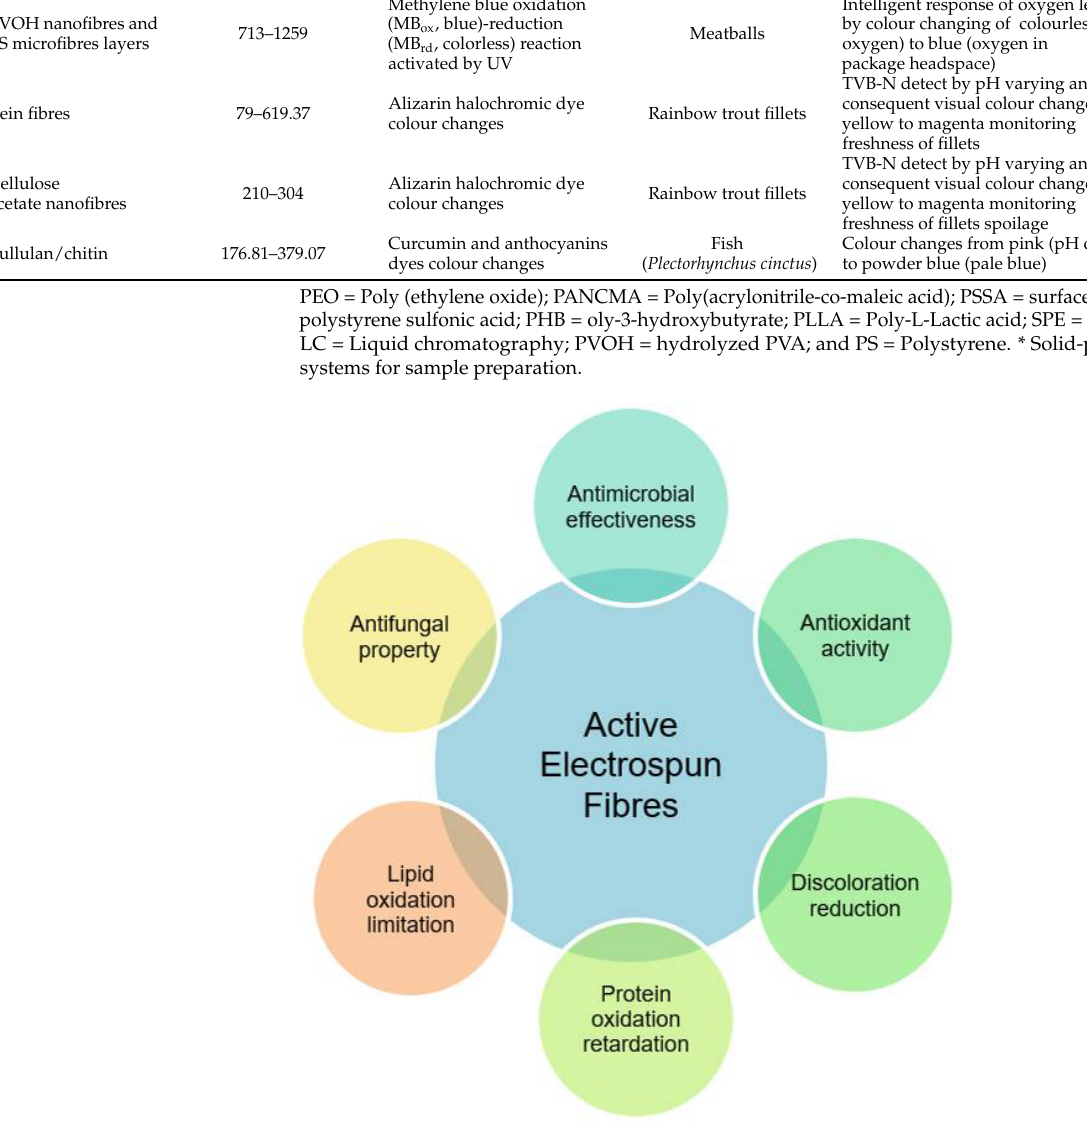
Figure 4. Benefits of active electrospun fibres in processing and preservation of meat and meat